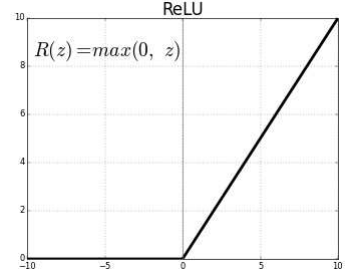
Figure 5. ReLU Graph